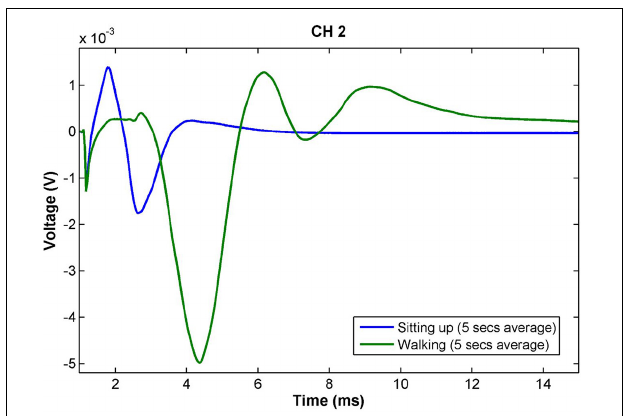
FIGURE 5 | Slow neural responses observed during a posture change in Patient 04 for stimulation on CH2 with constant stimulus parameters (14 Hz, 2.3 mA, 100 µ s pulse width). The amplitude of the neural response while walking is more than twice as large as that during sitting. Further, the latency and number of peaks increases, indicating a larger number of different fiber types and lower conduction velocity than in the sitting posture. The patient did not have any stimulation sensation during these measurements. Both traces are the result of averaging the responses obtained over 5 s of continuous recording (70